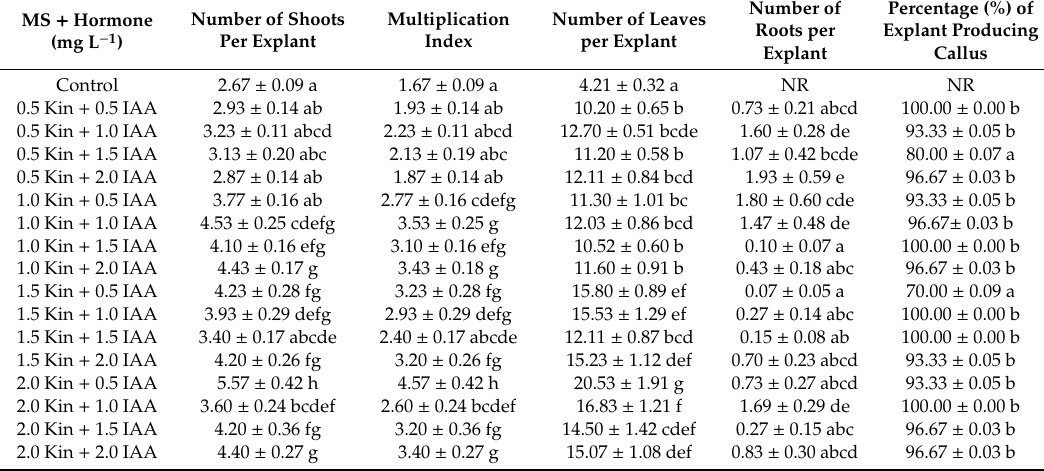
Table 2. E ff ects of combination hormones on number of shoots, multiplication index, leaves and roots per explant, and percentage (%) of explant producing